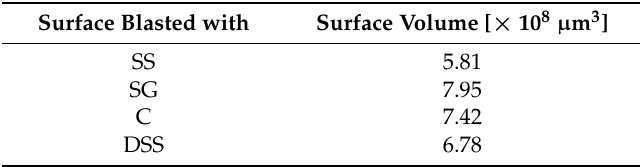
Table 7. Surface volume of evaluated